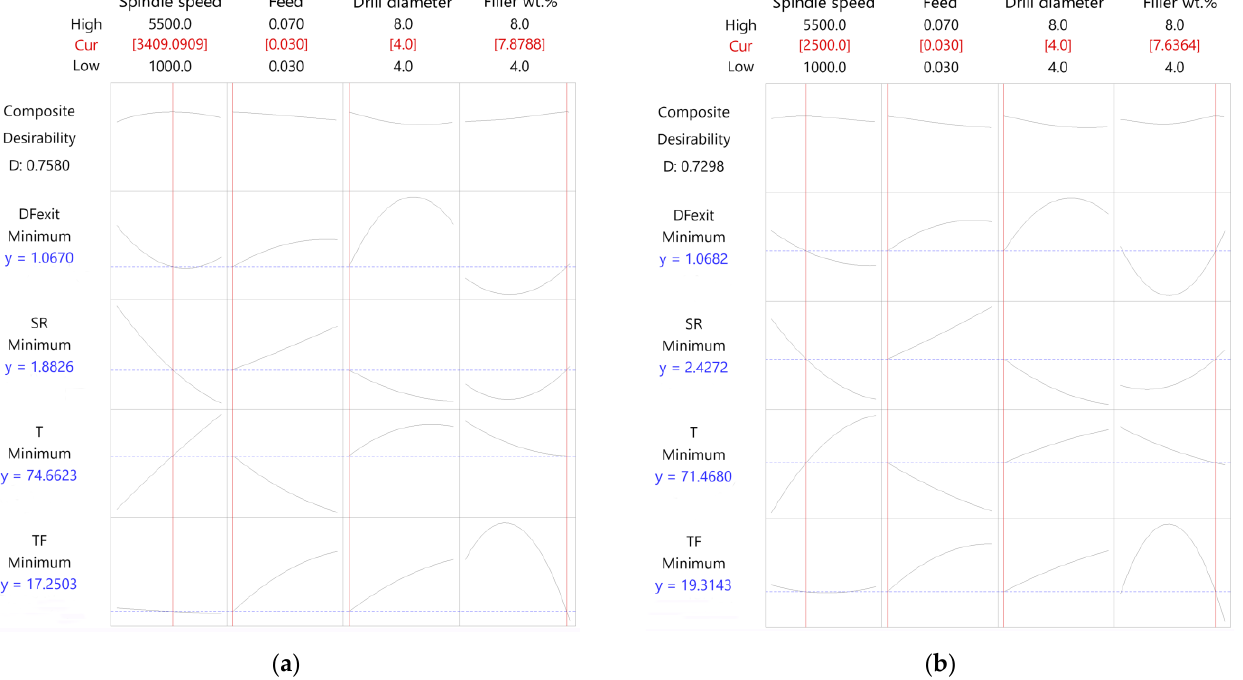
Figure 20. Response optimization desirability plot ( a ) MoS 2 -loaded CEC and ( b ) h-BN-loaded CEC.